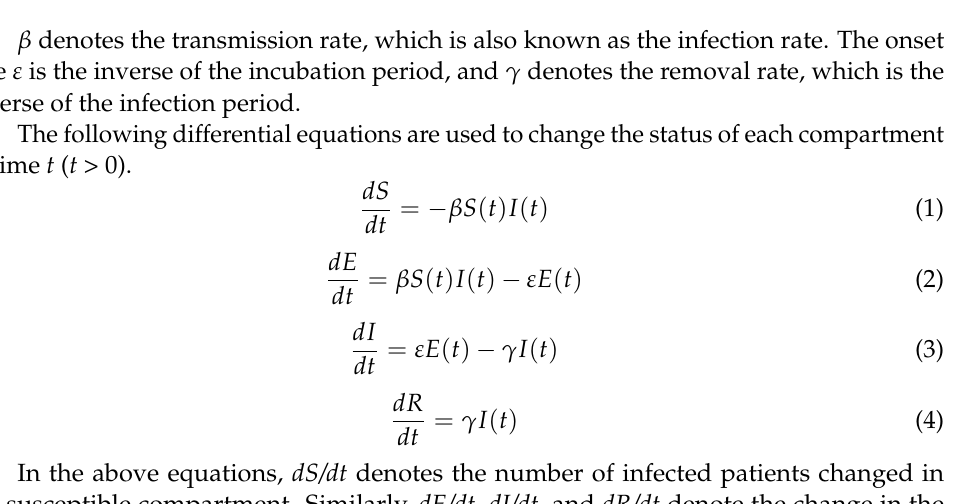
Figure 1. SEIR (Susceptible, Exposed, Infected, Removed)